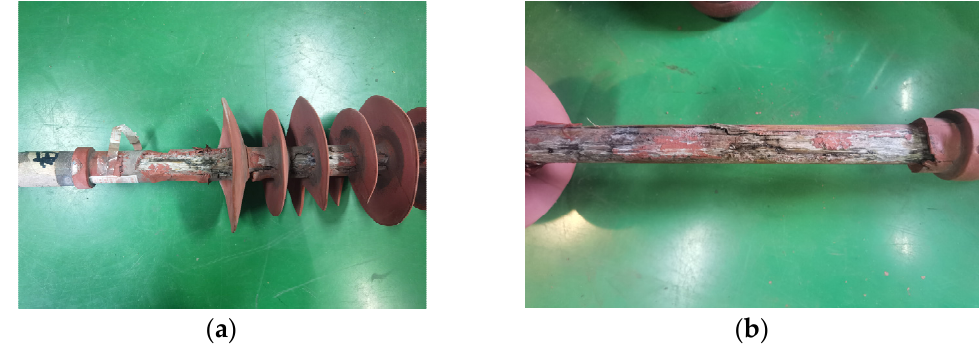
Figure 4. #1’s appearance and interior deterioration. ( a ) #1’s appearance; ( b ) without the skirts.